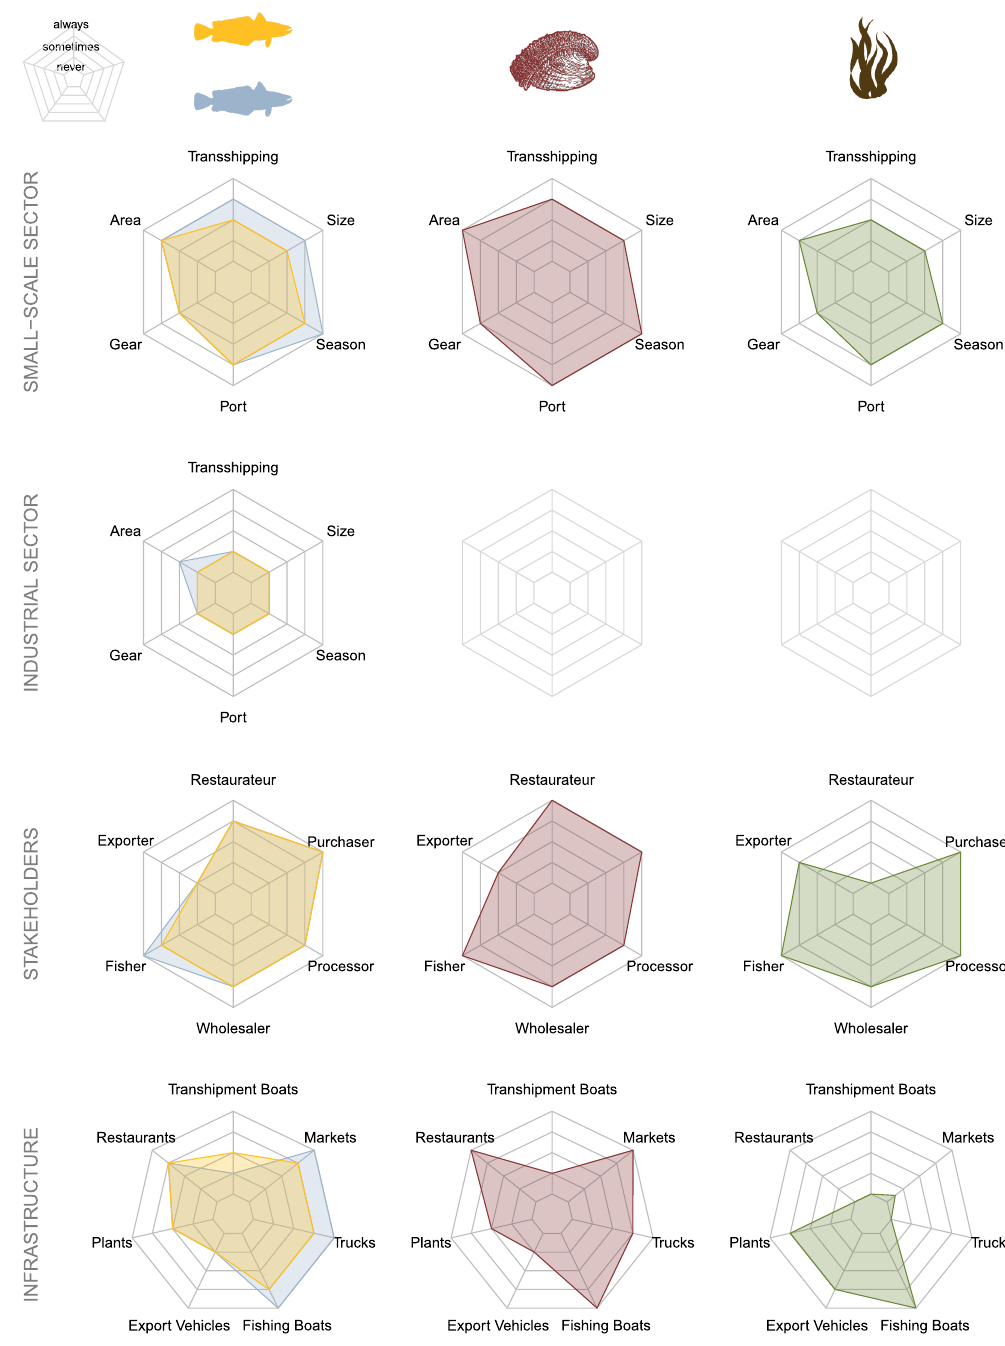
Figure 2. Fishery profiles of four Chilean fisheries: south Pacific hake (blue), southern hake (orange), Chilean abalone (red), and kelp (green). Predicted median estimates of the level of illegality in industrial sector activity, small-scale sector activity, stakeholders, and infrastructure. Industrial fishing does not exist for Chilean abalone and kelp. Predicted medians are from a Bayesian cumulative multinomial logit model for each of the four focal fisheries. The entire posterior distributions of the model results are shown in Figs.